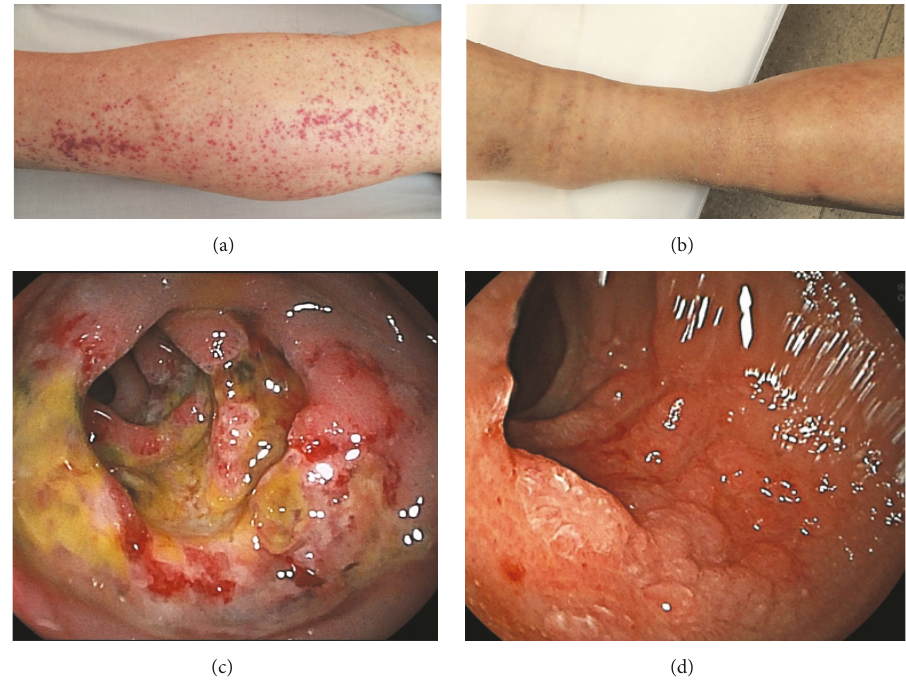
Figure 3: Changes of palpable purpura and duodenal ulcer before and after prednisolone administration. (a) Appearance of palpable purpura during the treatment of streptococcal cellulitis. (b) Improvement of palpable purpura after prednisolone administration for 2 weeks. (c) Severe duodenal ulcer with anaphylactoid purpura shown via endoscopy. (d) Improvement of duodenal ulcer after prednisolone administration for 2 weeks shown via